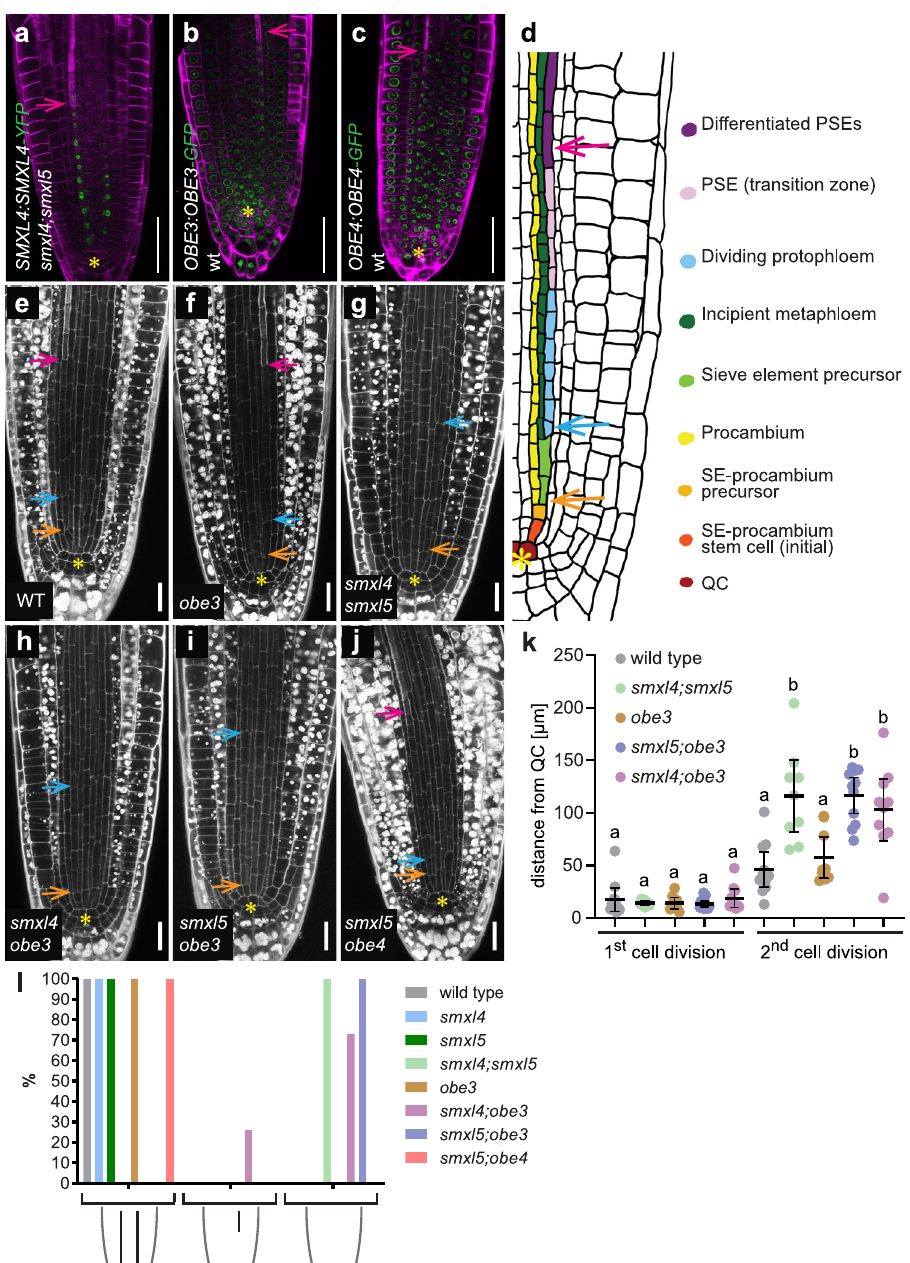
Fig. 6 | OBE3 interacts with SMXL5 in protophloem formation. a – c Phloem- speci fi c activity of SMXL4:SMXL4-YFP ( a ) coincides with activity of OBE3:OBE3-GFP ( b )and OBE4:OBE4-GFP ( c )reportersinthedevelopingphloem.Fluorescentsignals (green)andcellwallstainingbyDirectRed23(magenta)weredetectedbyconfocal microscopy. Pink arrows point to the fi rst differentiated SE indicated by enhanced cell wall staining. Scale bars represent 50 µ m. d Schematic representation of one developing phloem pole at the root tip. Two periclinal cell divisions generate SE precursor and procambium (orange arrow) and proto- and metaphloem cell lineages (blue arrow), respectively. Differentiated SEs are marked by a pink arrow. TheQCismarkedbyayellowasterisk.Figureadaptedfrom 61 . e – j Phloemformation in 2-day-old wild-type ( e ), obe3 ( f ), smxl4;smxl5 ( g ), smxl4;obe3 ( h ), smxl5;obe3 ( i ),